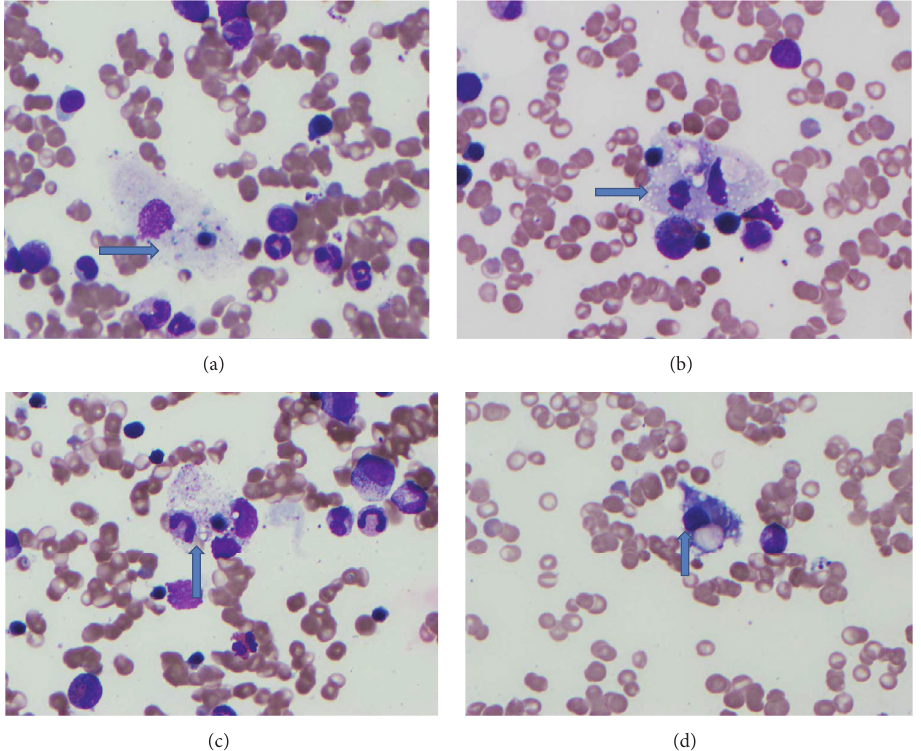
Figure 1: (a)–(d) Wright Giemsa stained bone marrow aspirate smear with increased number of histiocytes depicting hemophagocytosis (engulfed white and red blood cell